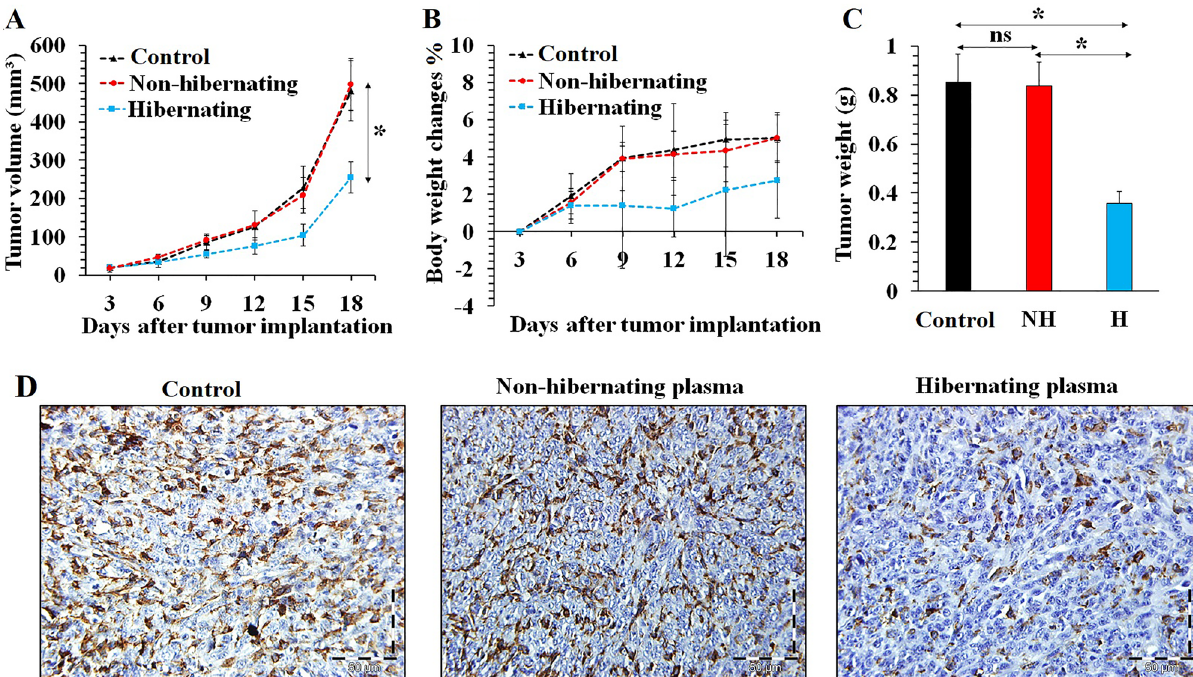
Figure 6. Evaluation of the anti-proliferative effect of hibernating plasma according to the tumor growth monitoring and the immunohistochemical analysis of the Ki-67 biomarker. ( A ) the mean tumor volume growth in the control ( n = 5), non-hibernating plasma ( n = 5), and hibernating plasma ( n = 5) groups. ( B ) The mean body weight of tumor-bearing mice in different groups ( n = 5). ( C ) The mean weight of tumors harvested on the 18th day after cancer cell implantation ( n = 5). ( D ) Immunohistochemical detection of Ki-67 in breast tumors harvested from different groups ( n = 5). ( NH non-hibernating, H hibernating, ns non-significant. *: P <